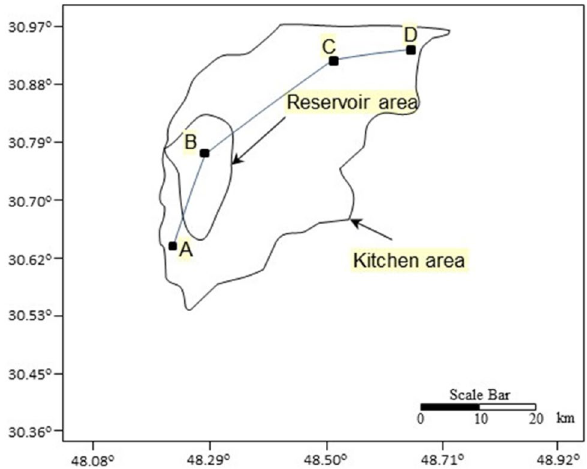
Fig. 12 Location map of pseudo-wells in the Jurassic kitchen area of the Darquain